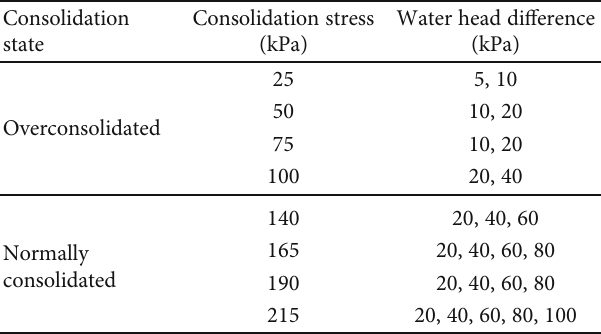
Figure 3: Schematic diagram of multistage ramp loading. Table 3: Permeability test scheme.